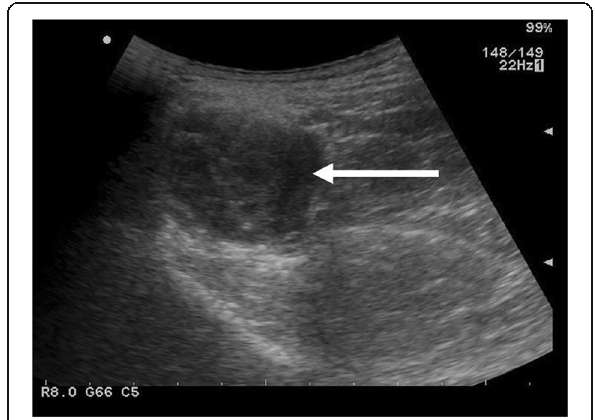
Fig. 3 US appearance of a DT of the gluteal region in a 33-year-old female